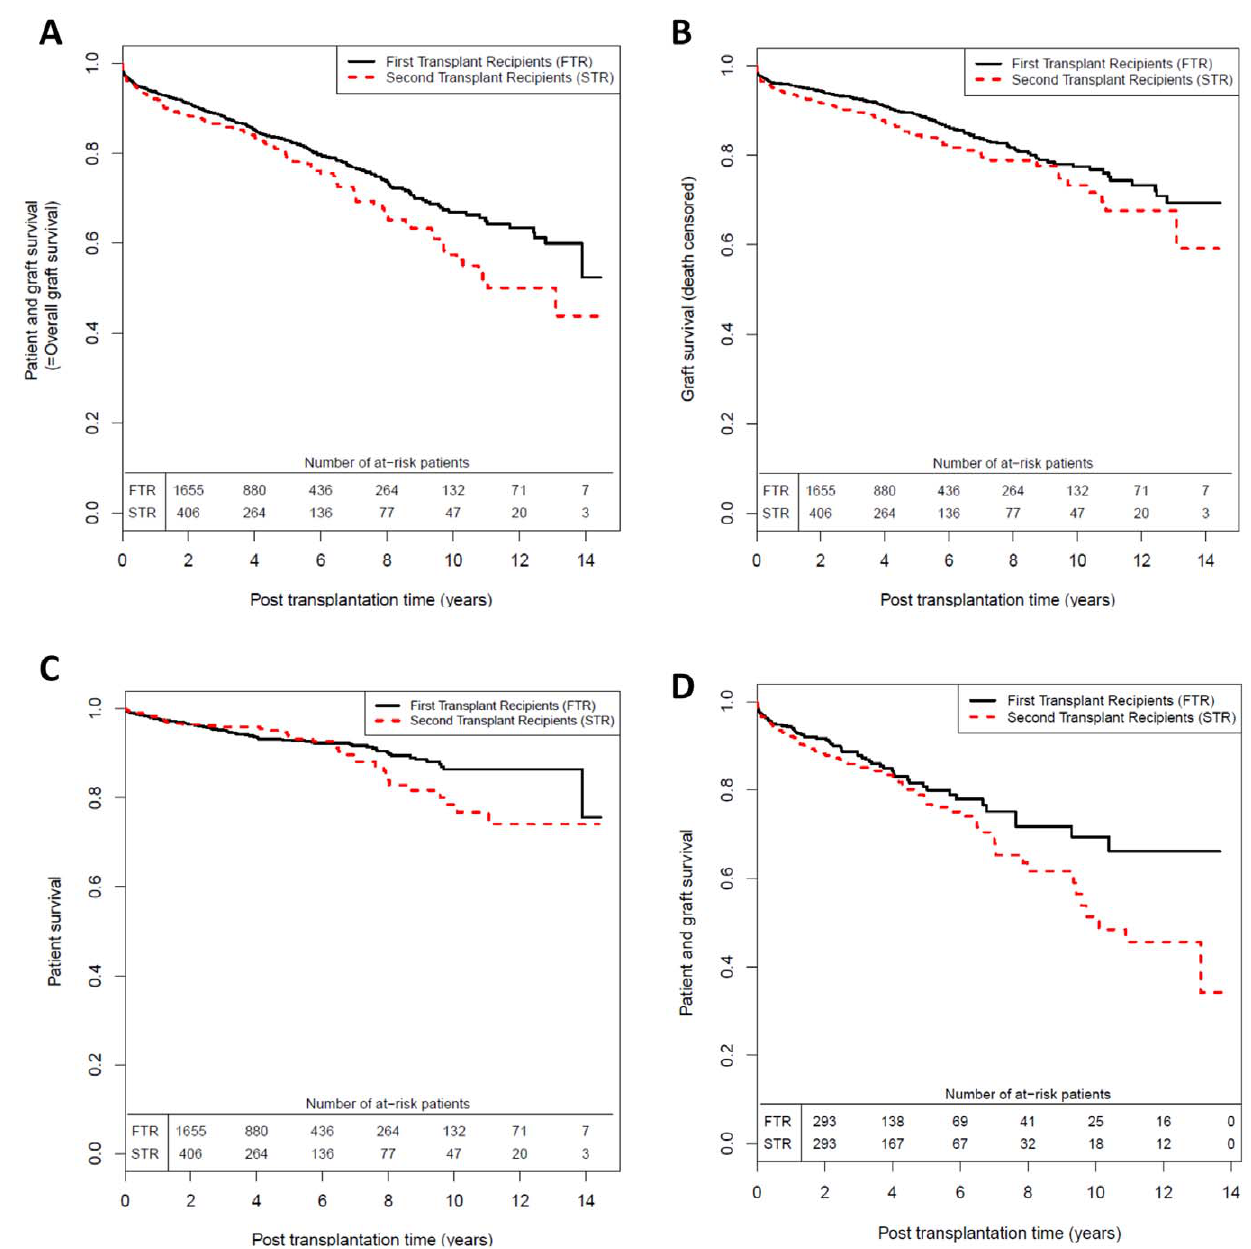
Figure 1. Unadjusted patient and/or graft survival analysis. ( A ) Patient-and-graft survival (=overall graft survival) : patient deaths with a functioning graft are considered as a graft failure (log-rank test: p=0.0127) ( B ) Death-censored graft survival: patient deaths with a functioning graft are censored (log-rank test: p=0.0206) and ( C ) Patient survival: returns to dialysis are censored (log-rank test: p=0.2890), for first and second grafts performed in the DIVAT network between January 1996 and November 2010 (Kaplan-Meier estimates). ( D ) Patient-and-graft survival sub-analysis for a sample of matched first grafts (N=486) and second grafts (N=486) for the following risk factors of graft failure: transplantation period, recipient age, history of cardiac disease, anti-class I PRA, recipient/donor relationship, BMI and EBV serology.